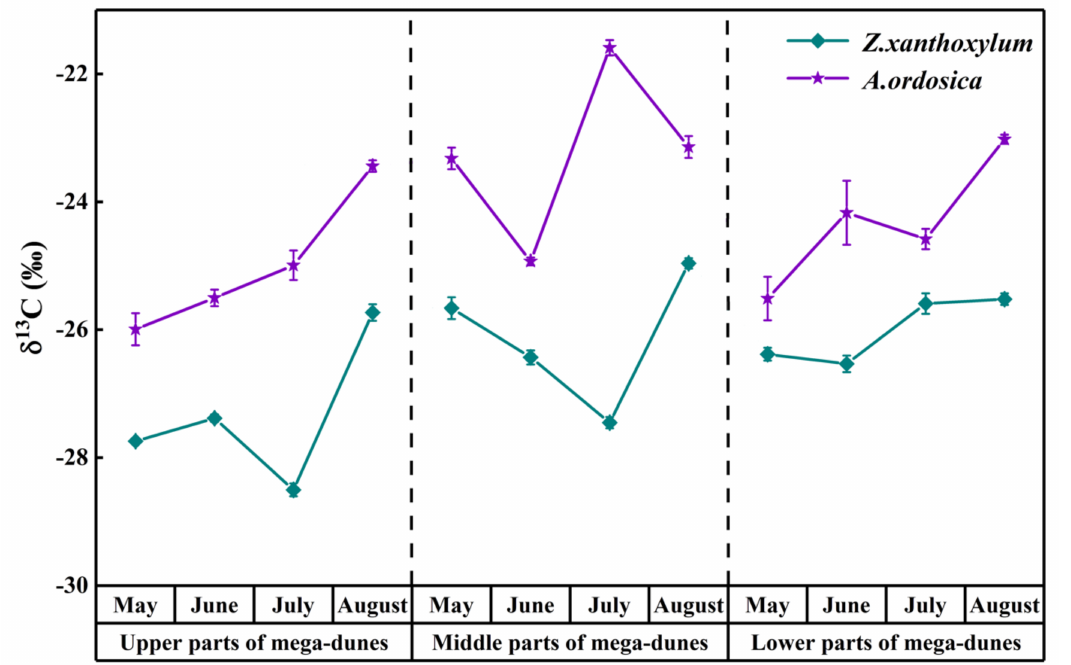
Figure 8. Spatio-temporal variations in δ 13 C values from Z. xanthoxylum and A. ordosica . Data are expressed as means ± 1SD.